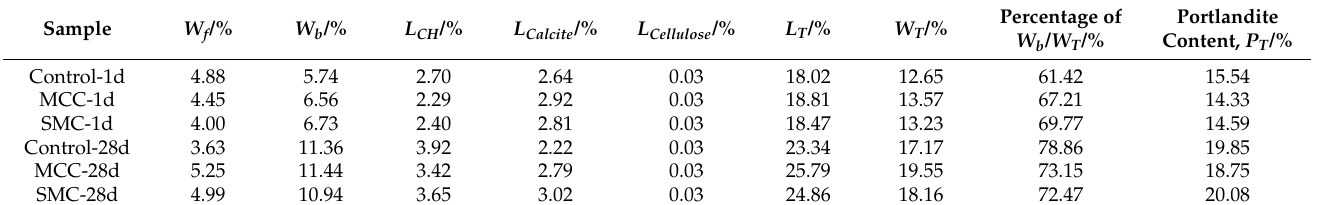
Table 3. The thermogravimetry results of samples.